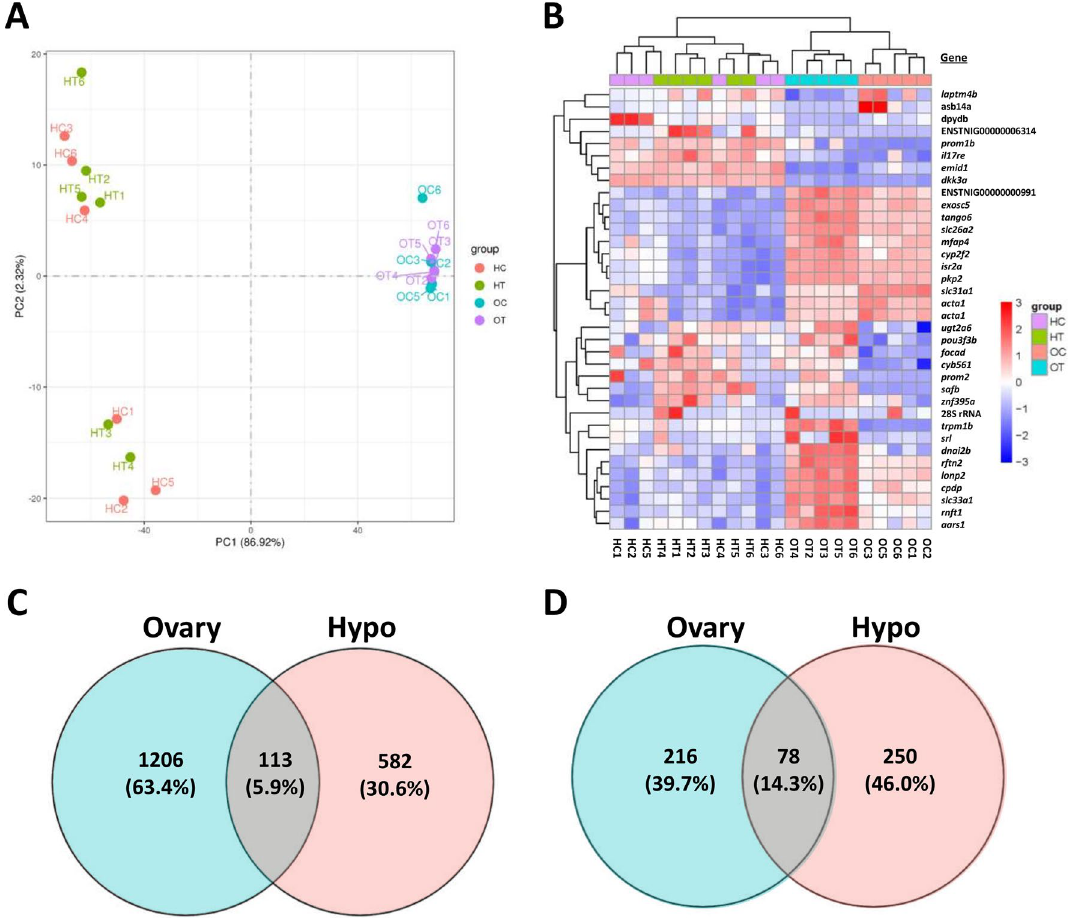
Figure 1. Principal component analysis ( A ) of transcriptomes in ovary control (OC, blue), ovary PNX-14 treated (OT, purple), hypothalamus control (HC, red) and hypothalamus PNX-14 treated (HT, green) samples. ( B ) Heat map of 36 differentially expressed genes (false discovery rate < 0.05) across both tissues, organized by genes (rows) and samples (columns). Gene names and individual sample IDs are provided on the right and bottom, respectively. Red colors indicate positive log2 fold changes in expression, while blue indicates negative changes. Unknown genes are labeled with their respective gene IDs identified in the Ensembl puffer genome (TETRAODON 8.0). ( C ) Total differentially expressed genes (P < 0.05) or ( D ) pathways with percentages (%) in the PNX-14 treatment in ovary (blue) and hypothalamus (red) transcriptomes, with shared entries across both transcriptomes identified in the middle